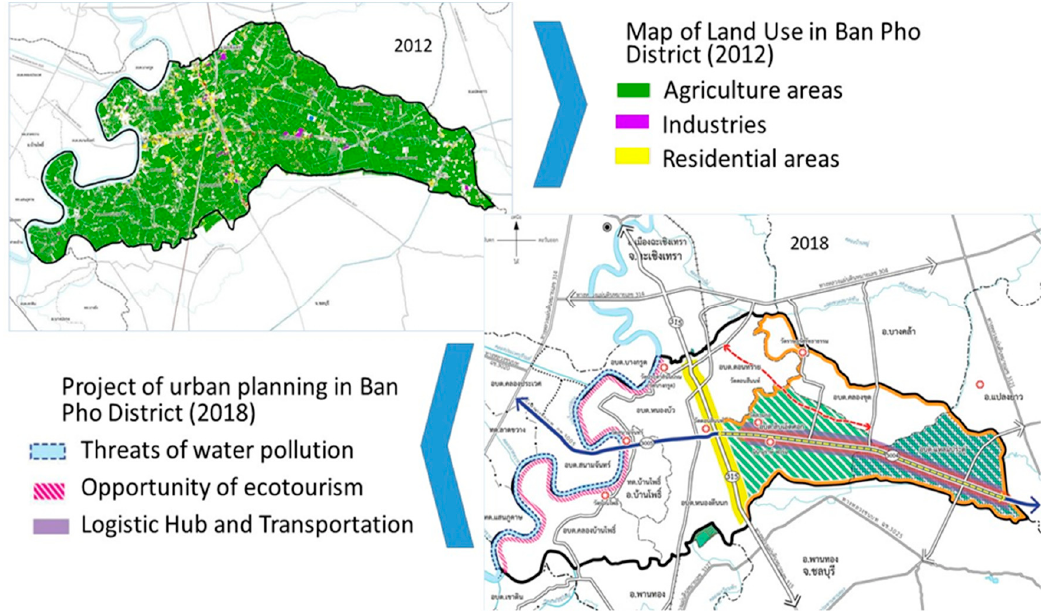
Figure 3. Map of land use in Ban Pho district in 2012 and 2018. Source: Department of Public works and Towns and Country Planning.